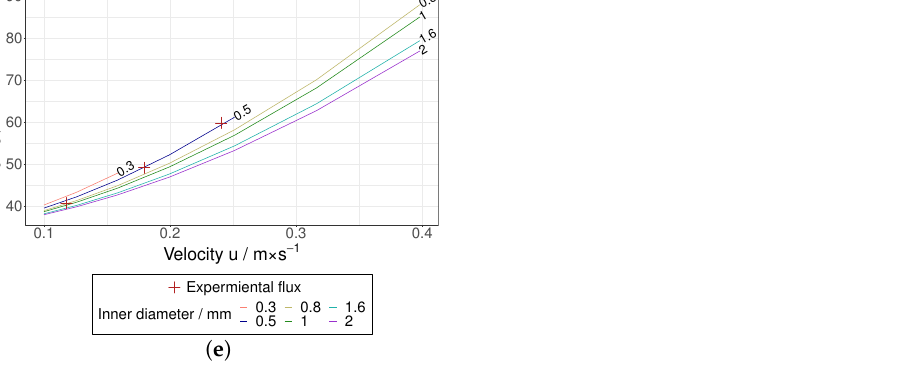
Figure 12. Flux over the velocity u for different d H from 0.3mm to 2mm based on Schock for the five different CS. The curves are limited for a γ W of 4500s − 1 and a Re of 2300; ( a ) 4CS 100kDa, ( b ) 4CS 300kDa, ( c ) 4CS 500kDa, ( d ) 4CS 750kDa, ( e )